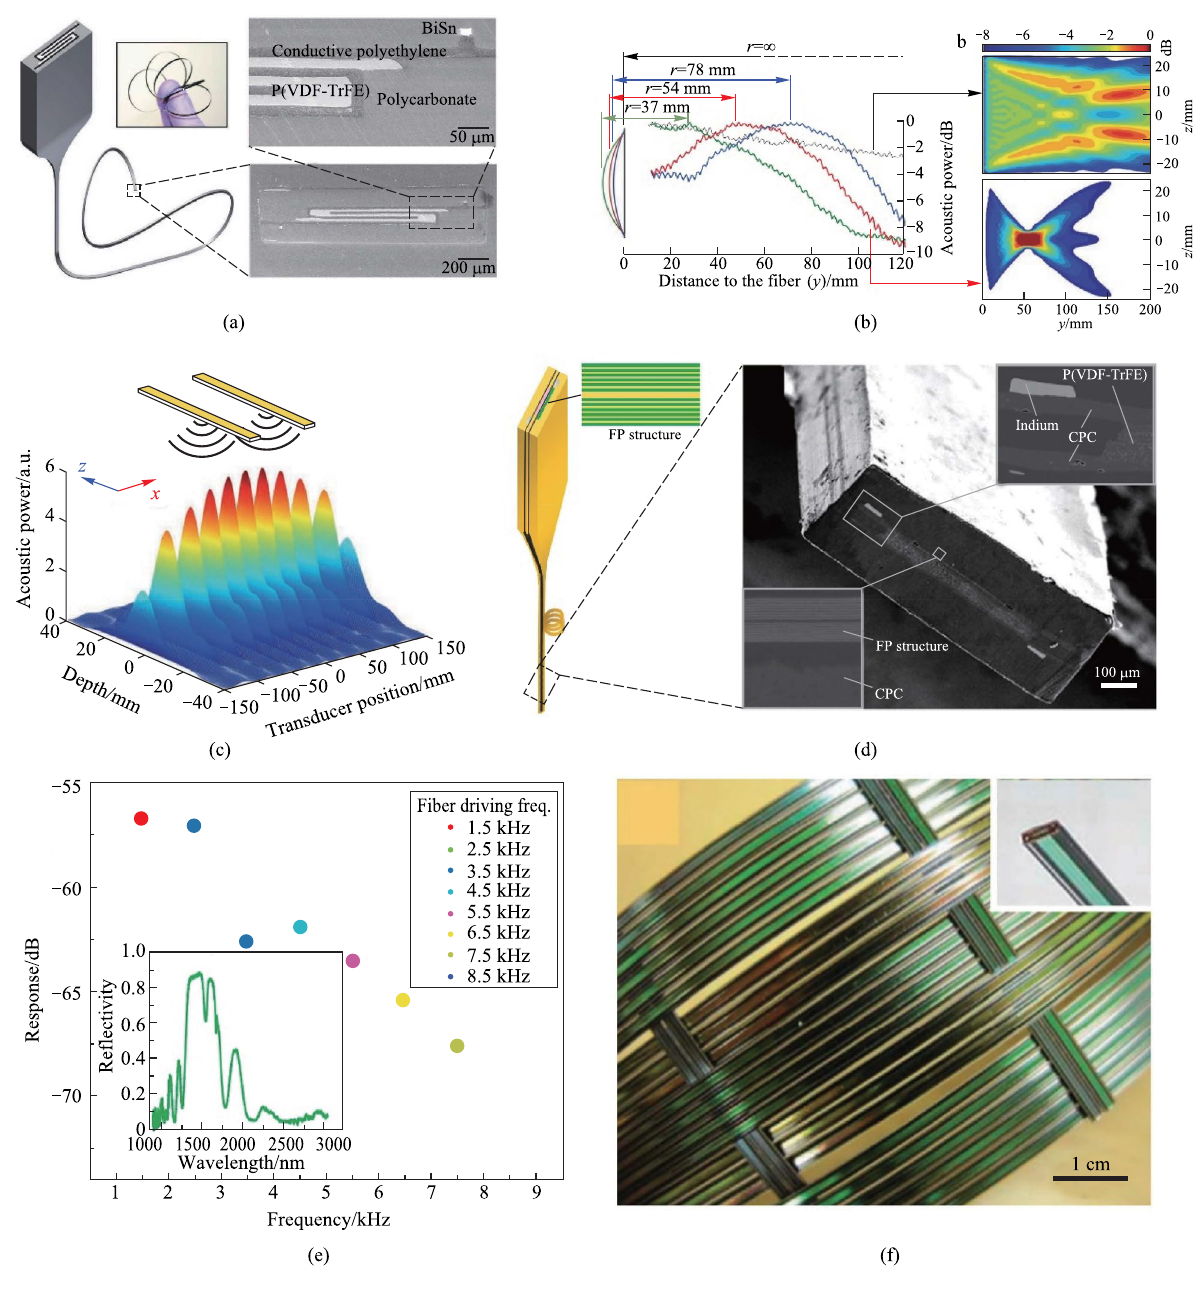
Fig. 9 TDPFs used for actuating and modulating. a Structure of a rectangular TDPF for acoustic actuating and its SEM images. b Measured and simulated acoustic power field produced by a bent TDPF. c 3D representation of the acoustic pressure field of a two-fiber array emitting in phase. d Fabrication process and structure of an integrated piezoelectric Fabry–Pérot (FP) rectangular TDPF for optical modulation. e Piezoelec- tricity and reflection spectrum of the integrated TDPF. f Two-dimensional device fabric constructed by knitting the piezoelectric/Fabry–Pérot TDPF fibers as threads. Reprinted with permission from Refs. [55,